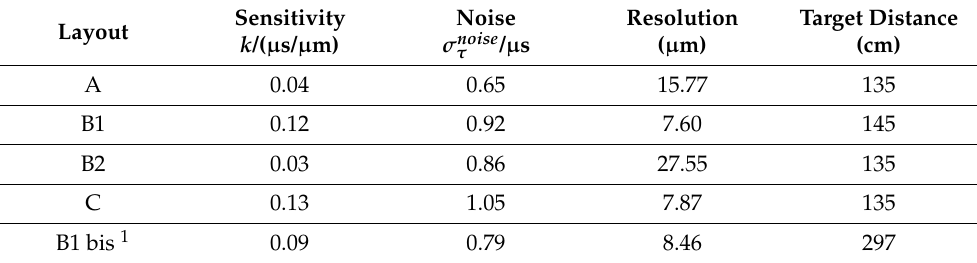
Table 1. Results of the resolutions for the P1